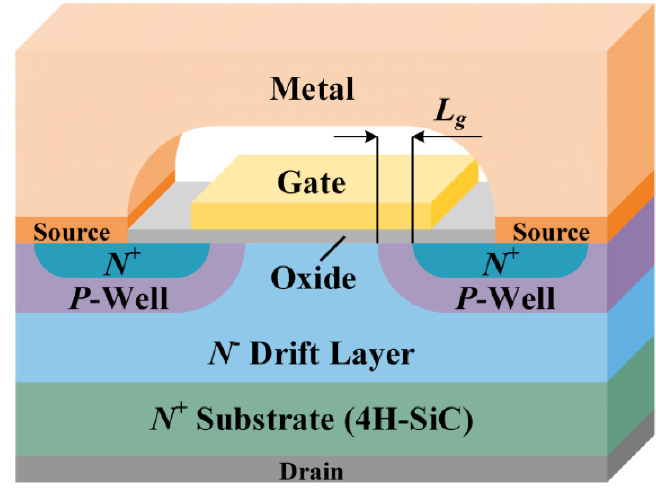
Figure 1. Schematic cross-sectional view of a 4H-SiC VDMOSFET elementary cell.